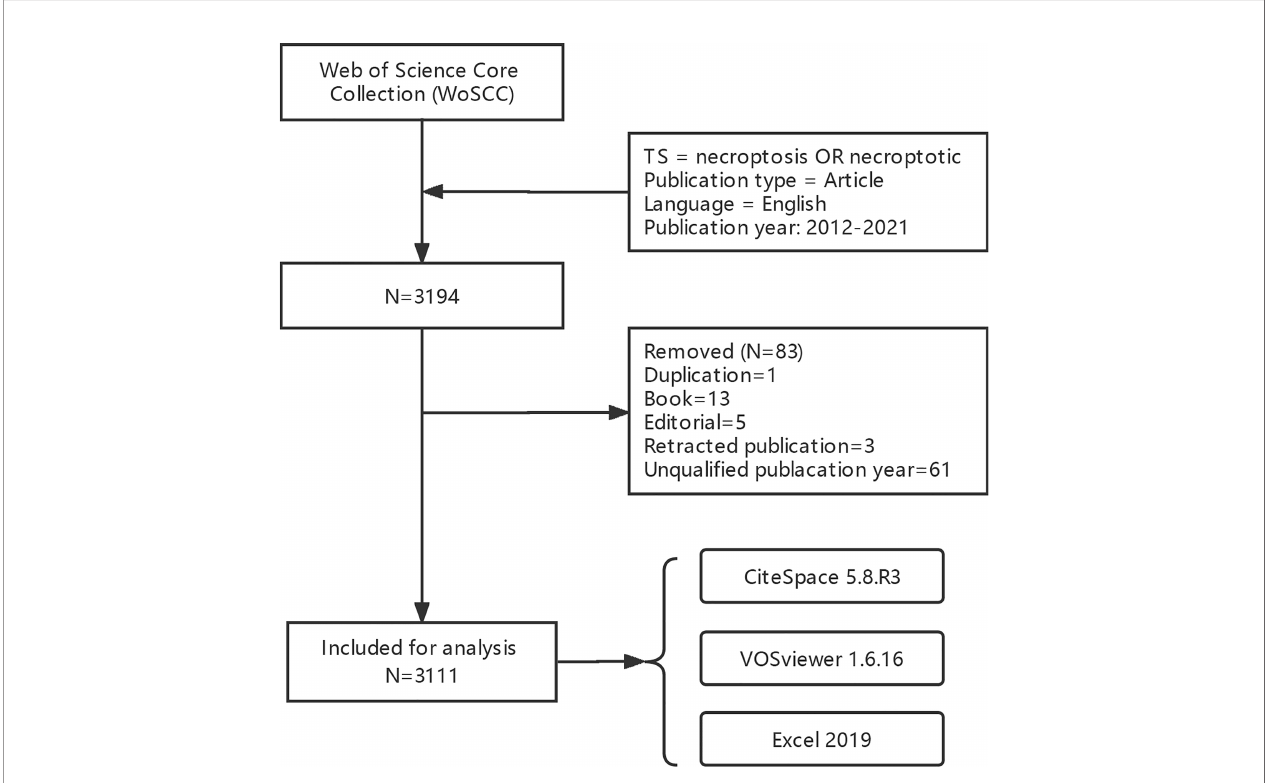
FIGURE 1 | Flow chart of data